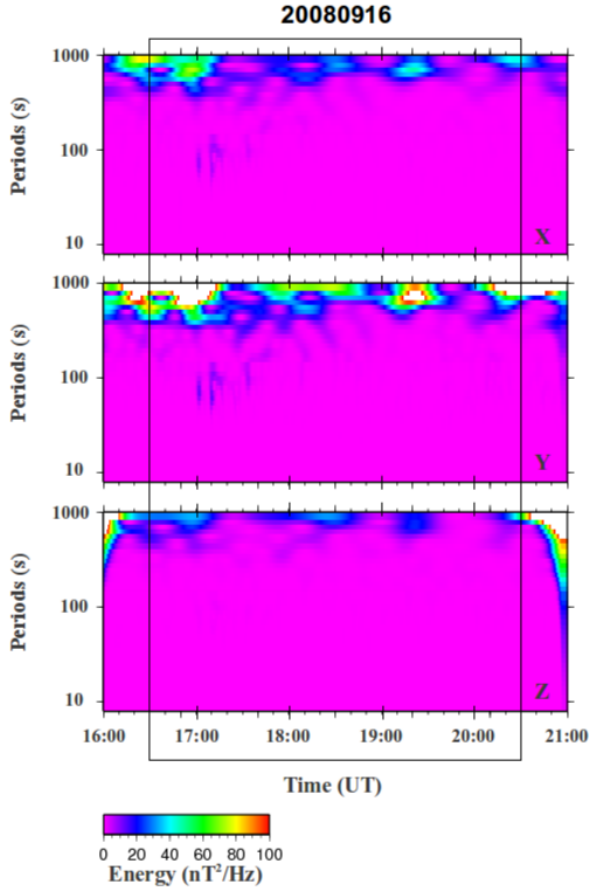
Fig. 6. An example of the wavelet spectrogram. The first, second, and third panels indicate X,Y, and Z components from 16:00 to 21:00UT on 16 September 2009, respectively.